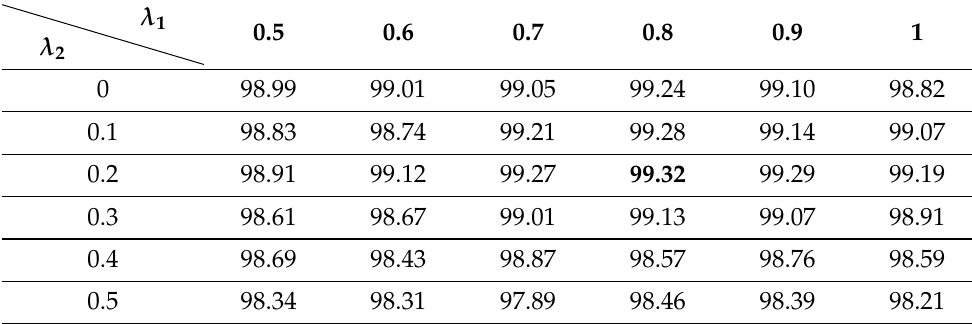
Table 7. Overall accuracy in the PaviaU data set with different λ 1 and λ 2 .